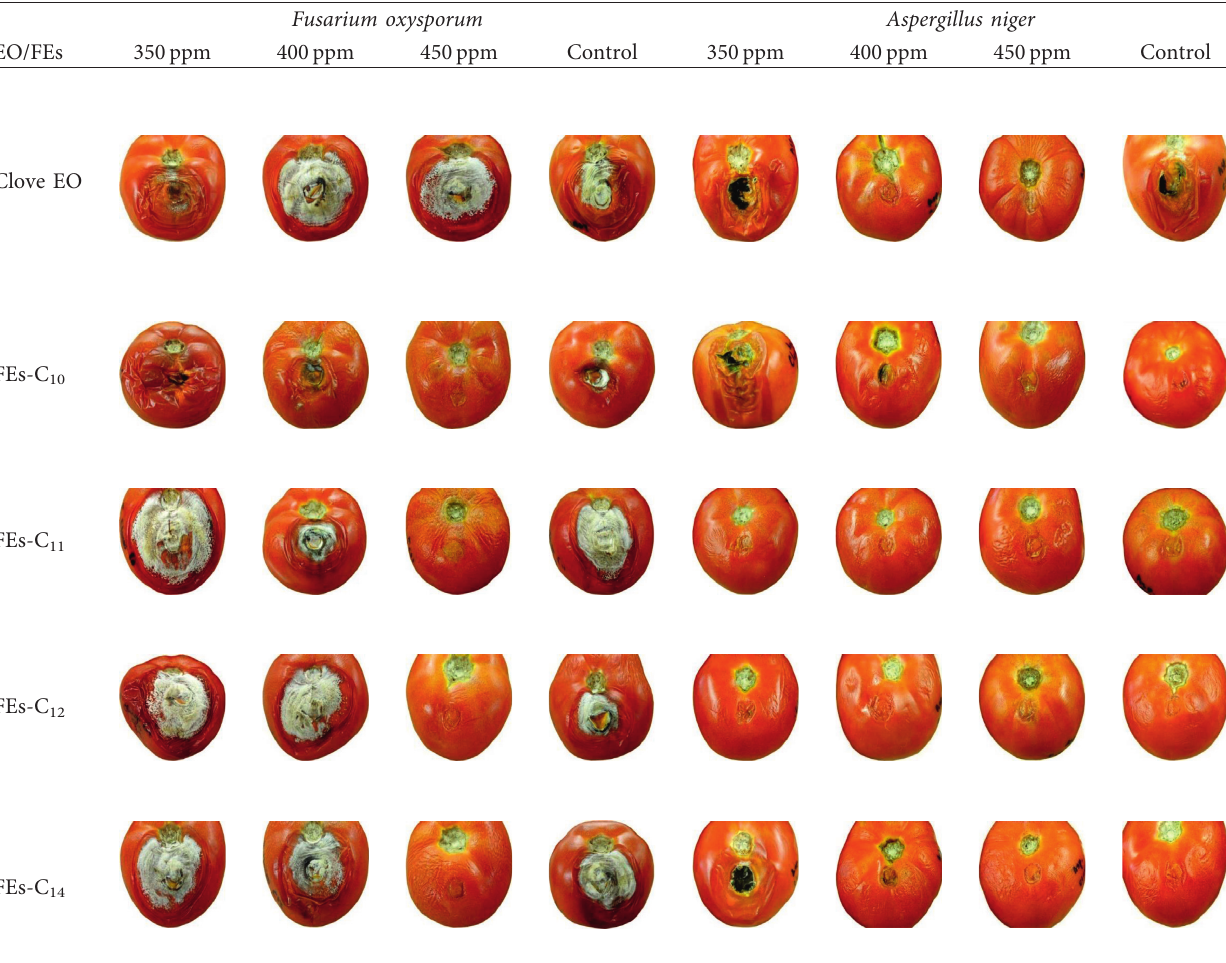
Table 4: In vivo antifungal activity of clove essential oil and functional extracts at Solanum lycopersicum L var